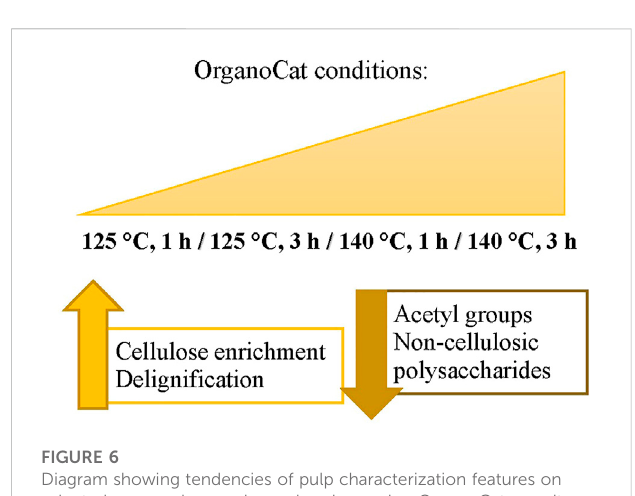
FIGURE 6 Diagram showing tendencies of pulp characterization features on selected rapeseed accessions when increasing OrganoCat